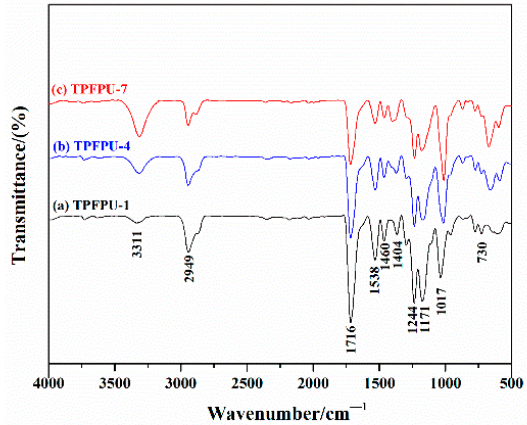
Figure 2. IR spectra of ( a ) TPFPU-1, ( b ) TPFPU-4 and ( c ) TPFPU-7.